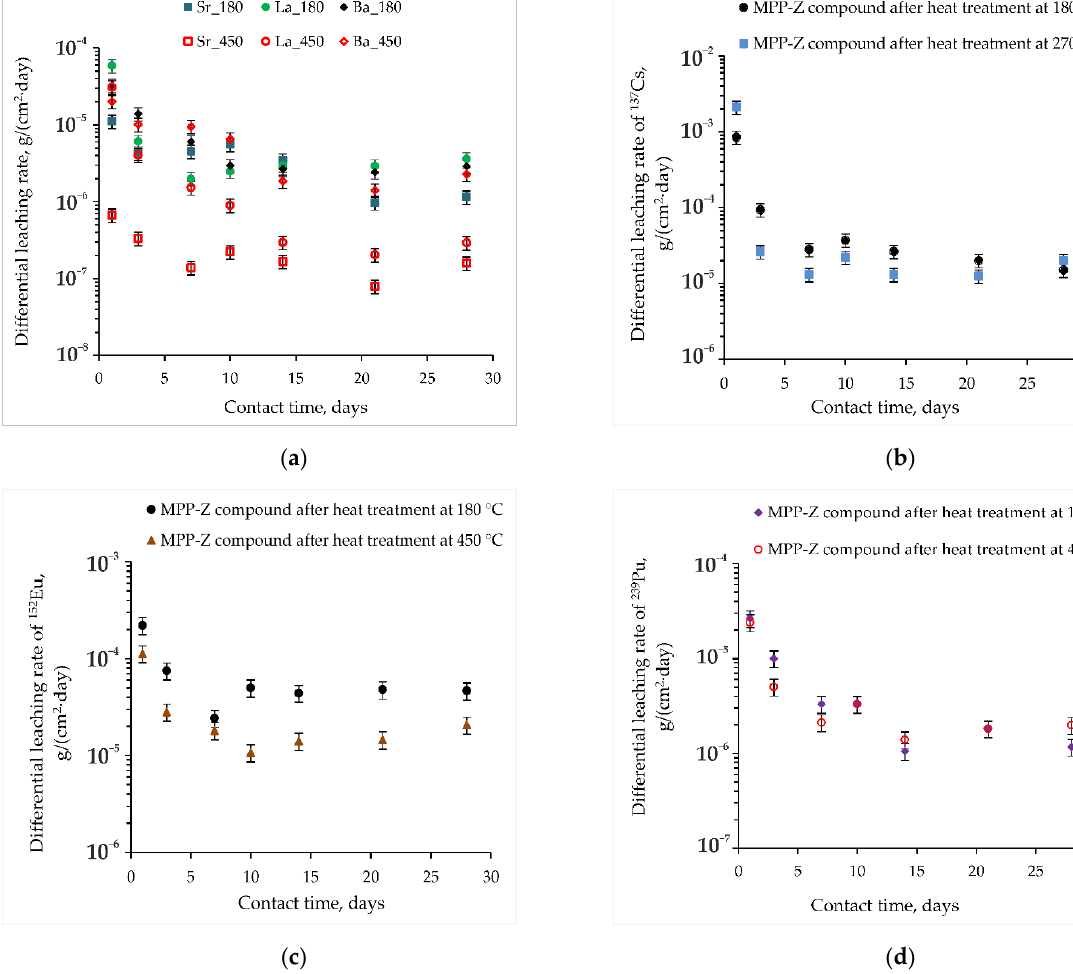
Figure 7. Kinetic curve of the leaching rate of ( a ) of the solidifying waste imitator components ( b ) 137 Cs, ( c ) 152 Eu and ( d ) 239 Pu from MPP-Z compound, including after its heat treatment.